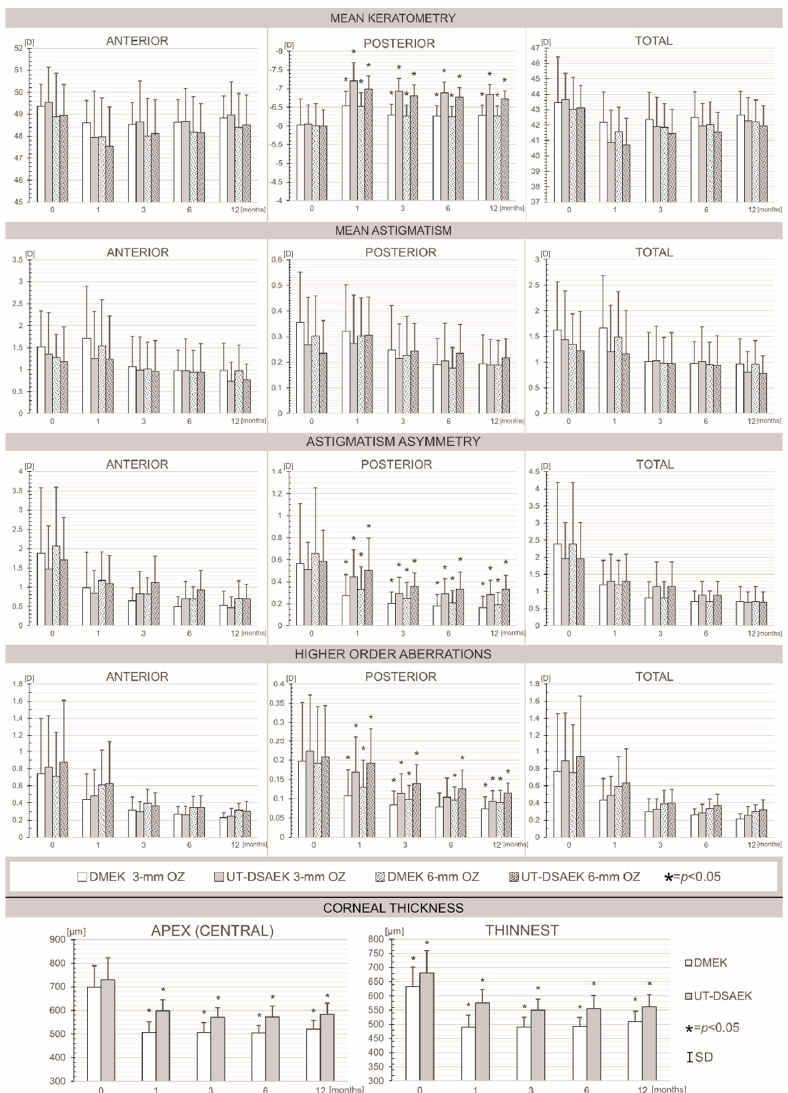
Figure 1. Bar graphs showing the pre- and postoperative mean values of the corneal parameters, which were evaluated using swept-source AS-OCT: mean keratometry, mean astigmatism, astigmatism asymmetry, higher-order aberrations and corneal thickness at the baseline and 1, 3, 6 and 12 months after Descemet membrane endothelial keratoplasty (DMEK) versus ultrathin Descemet stripping automated endothelial keratoplasty (UT-DSAEK) measured in 3 and 6 mm optical zones (OZs). * p < 0.05.